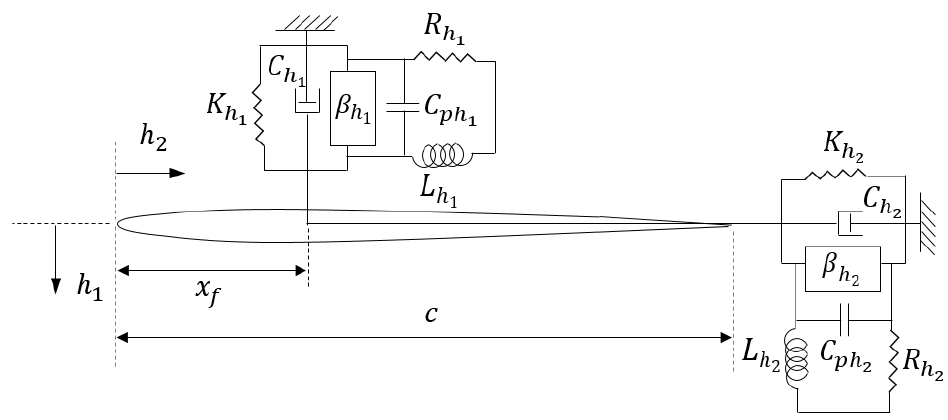
Figure 1. A smart blade with flapwise and edgewise plunge and rotational DOFs. By assuming a constant rotational velocity, the smart blade equations of motion with two plunge and rotational DOFs in free vibrations can be written as